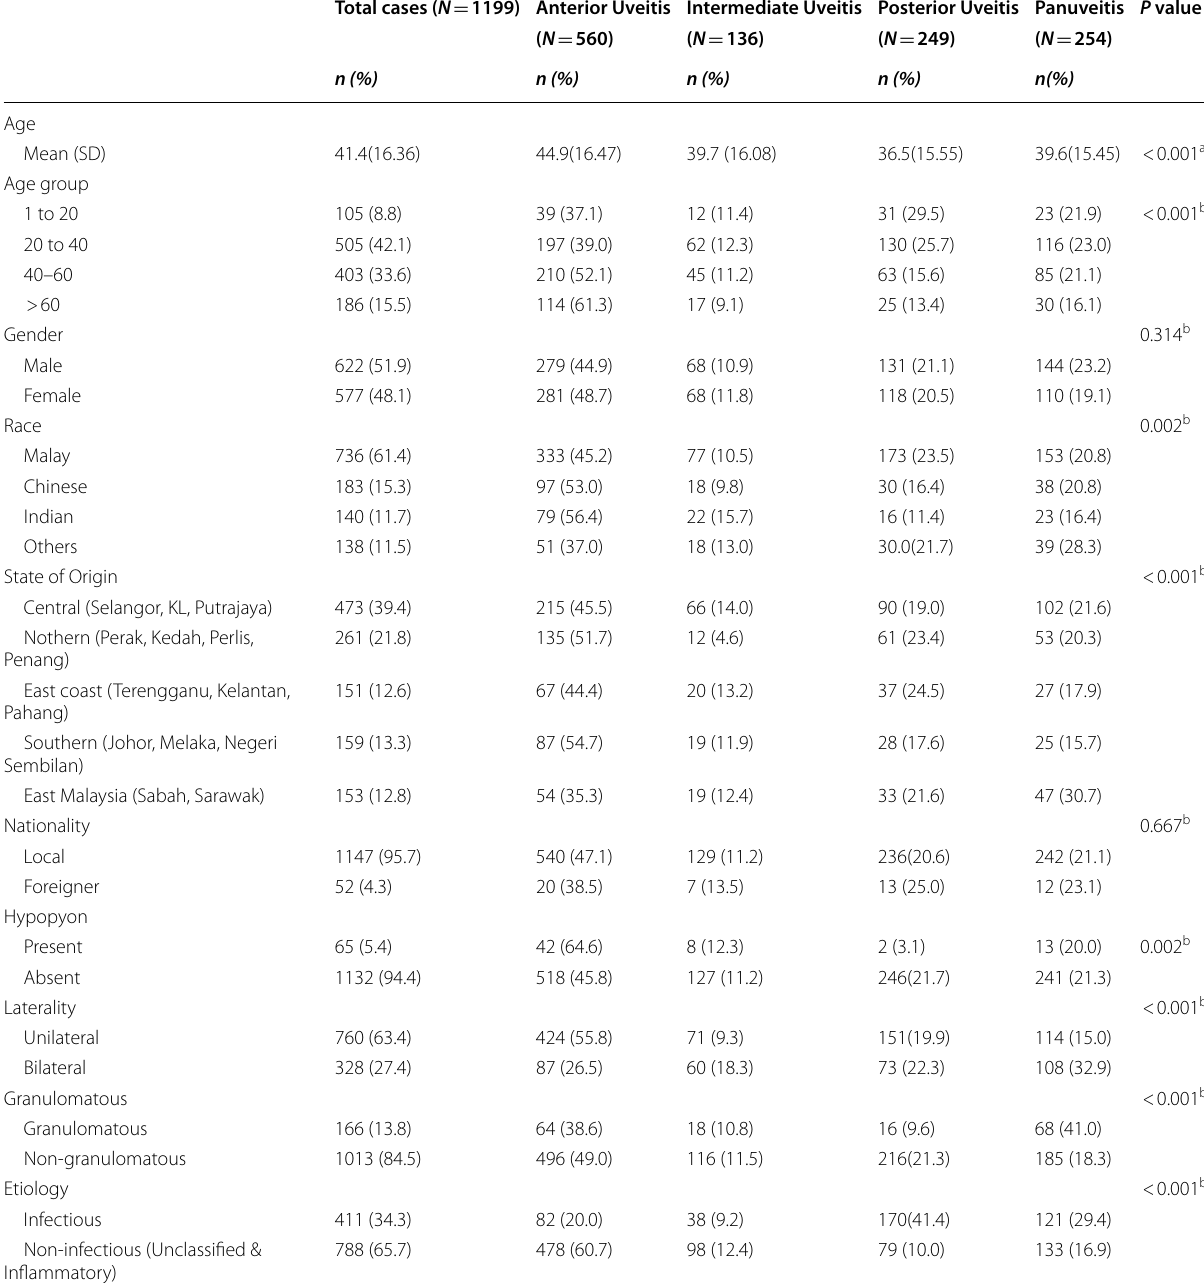
Table 1 Demographic Data and Clinical Features according to SUN